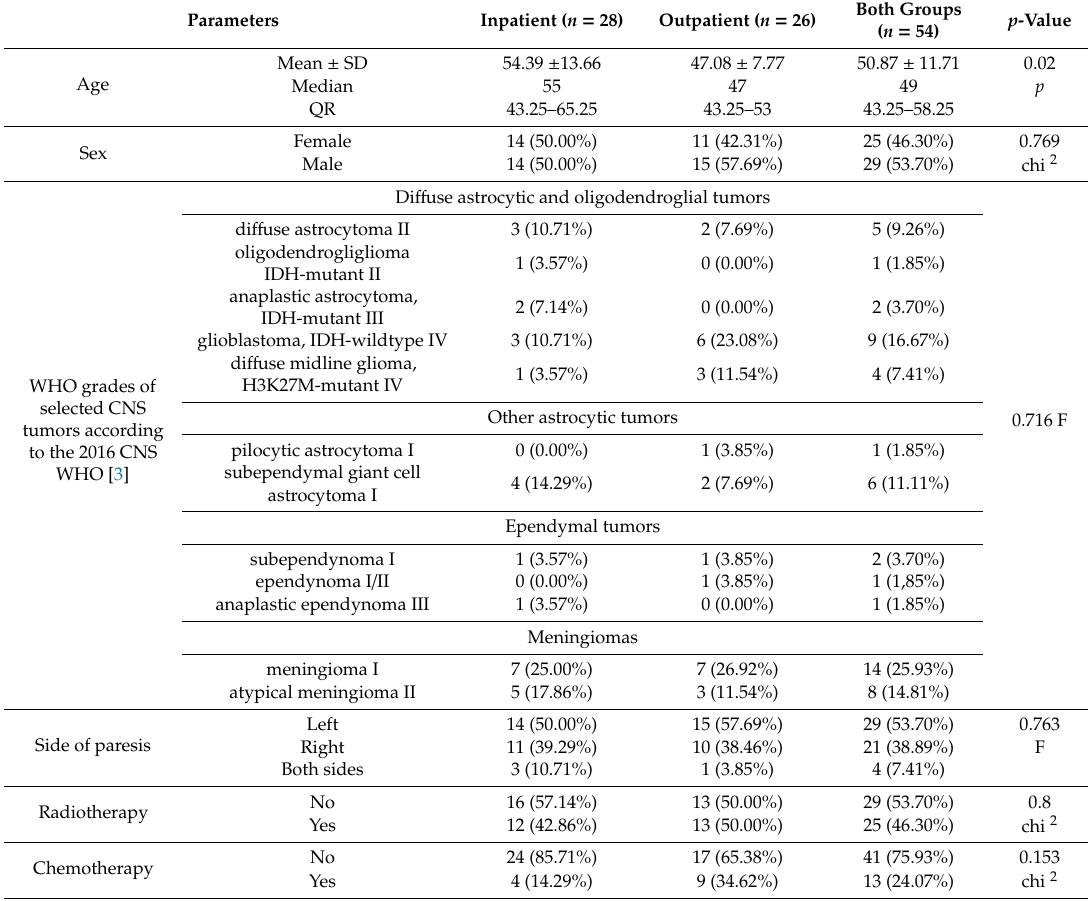
Table 1. Characteristics of the study